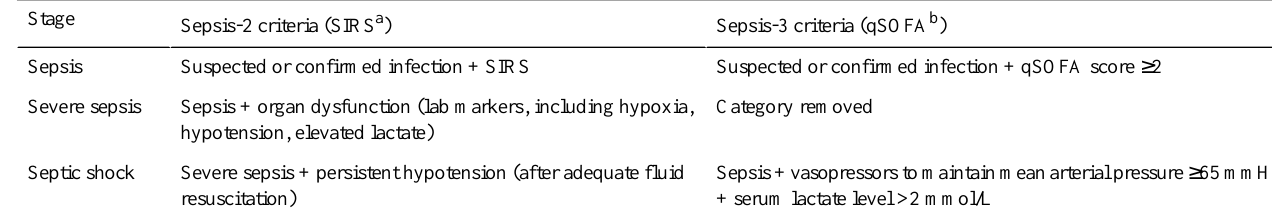
Table 2. Comparison of sepsis-2 and sepsis-3